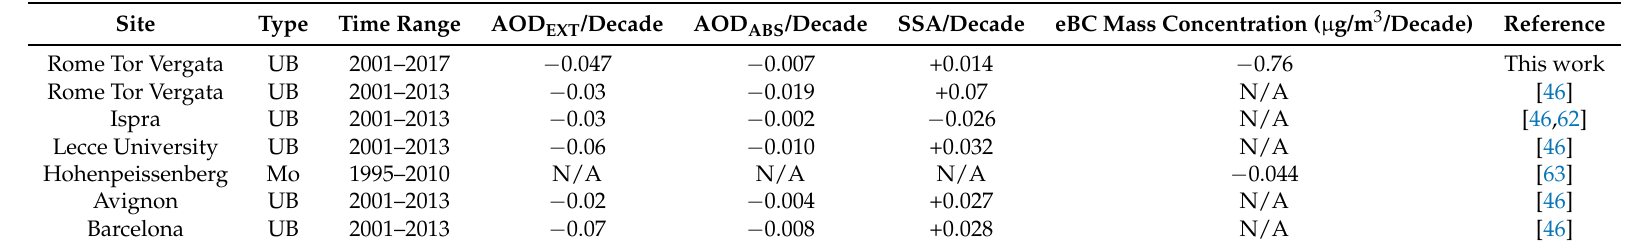
Table 5. Comparison between trends estimated in Rome and across other Italian and European sites. Site categories are: UB = urban or suburban, Mo = mountain. N/A = not available